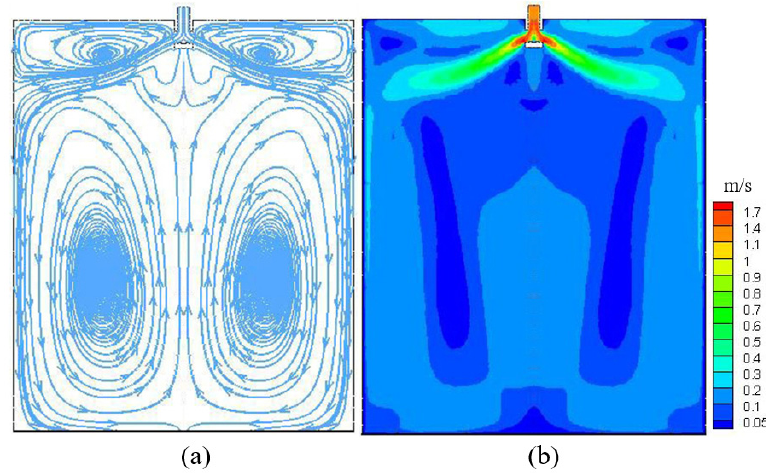
Figure 8. Fluid contours: ( a ) trajectory line; and ( b ) flow field at a thickness of 220 mm.